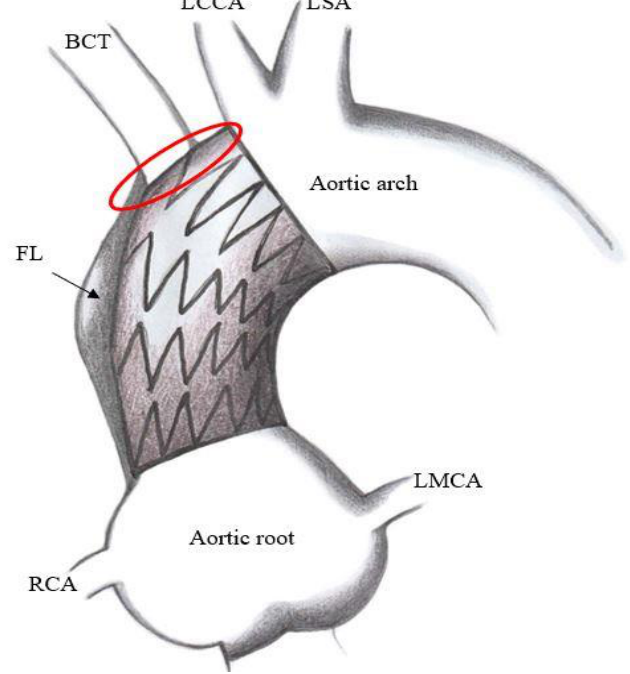
Figure 3. Representation of type A aortic dissection treated with a too long endoprosthesis, covering supra-aortic vessel origins. Red circle indicates supra-aortic vessel covering by the endoprosthesis. BCT = brachiocephalic trunk; FL = false lumen; LCCA = left common carotid artery; LMCA = left main coronary artery; LSA = left subclavian artery; RCA = right coronary artery.